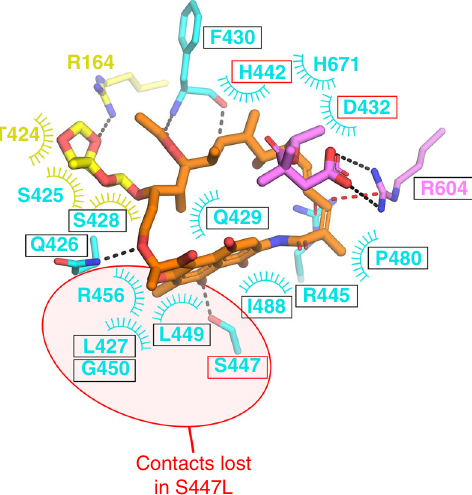
Fig. 5 Kang A contacts with wild-type and Rif R RNAP. Schematic summary of the Kang A/RNAP β subunit contacts. Residues that make only nonpolar contacts are shown as labels with arcs denoting the contacts. The side chains (or main chain atoms for F430) of residues that make polar contacts are shown in stick format (H-bonds, gray dashed lines; cation- π interactions, red dashed lines). The color-coding of residues/residue labels is as follows: residues that contact the Rif scaffold in the Rif/RNAP structure, cyan; residues that also make nonpolar contacts with K-sugar, yellow arc; residues that contact K-sugar but do not contact the Rif scaffold, yellow. R604 (colored violet) makes a cation- π interaction with the Rif scaffold but also makes a salt bridge with K-acid. Residues that confer Rif R when substituted are denoted by colored boxes as in (A). Residues that lose contacts with Kang A in the Rif R S447L RNAP mutant are denoted by red background